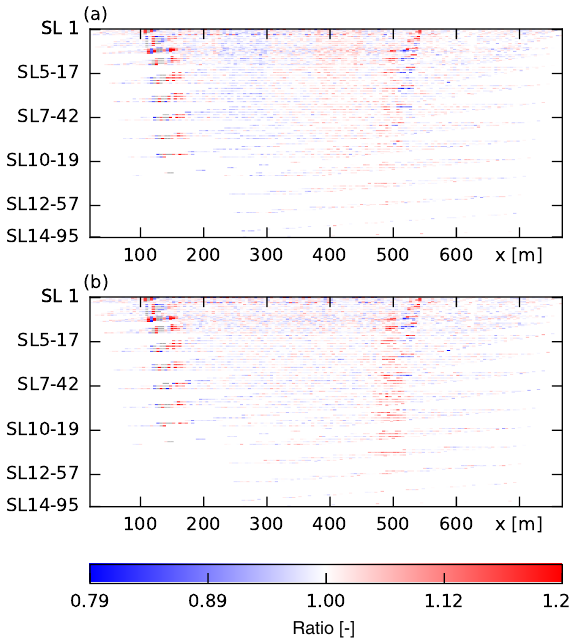
Figure 7. Pseudo-section of the synthetic data for the gradient ar- ray. The ratios between case one and the reference model (a) and between case two and the reference model (b)